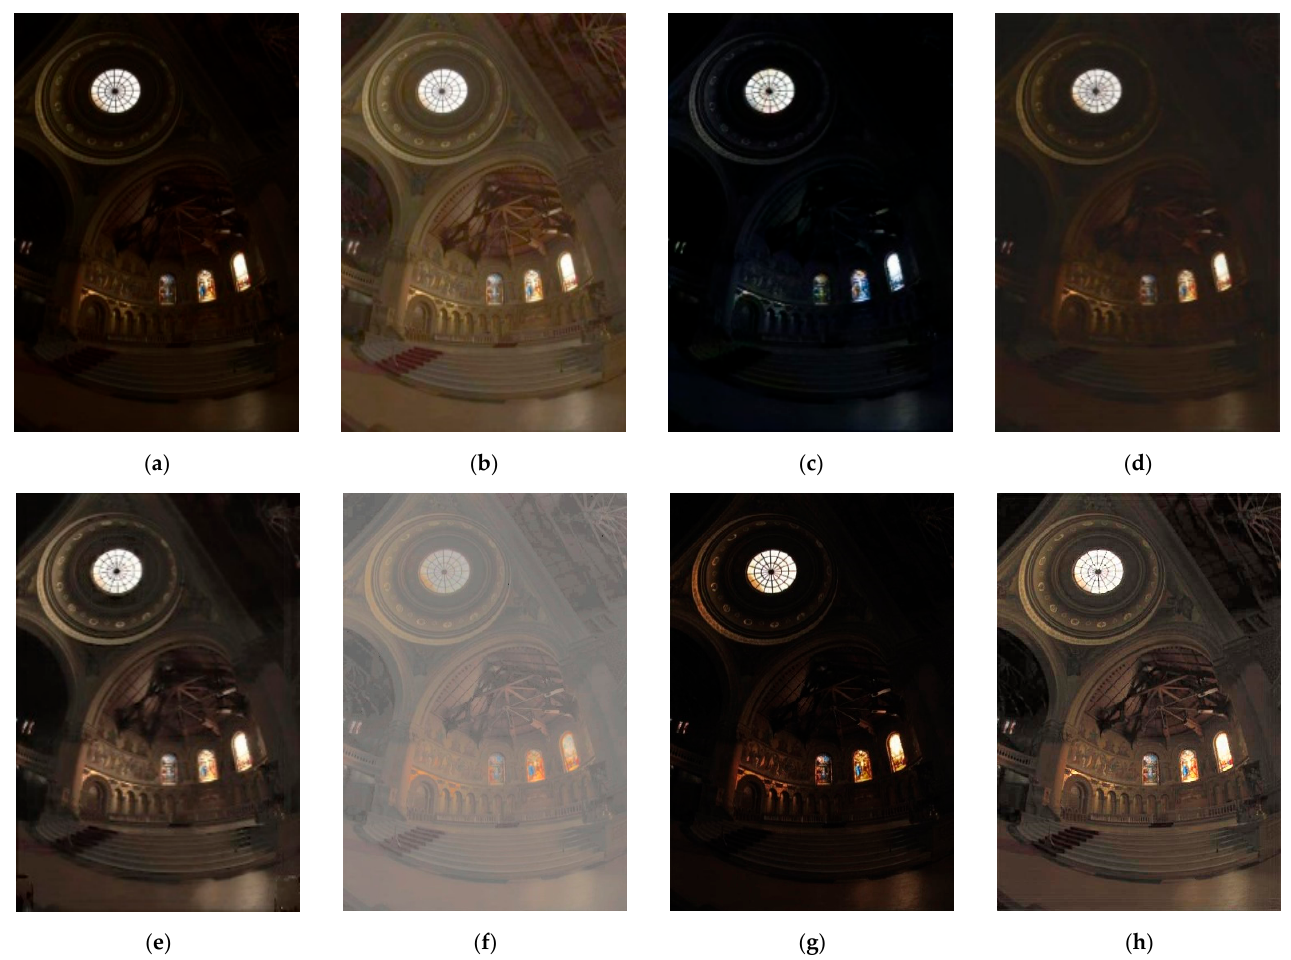
Figure 13. Dark surrounding image #1: ( a ) input, ( b ) target, ( c ) CycleGAN, ( d ) Lum CycleGAN, ( e ) EV GAN, ( f ) HDRCNN, ( g ) ExpandNet, and ( h ) the proposed model.